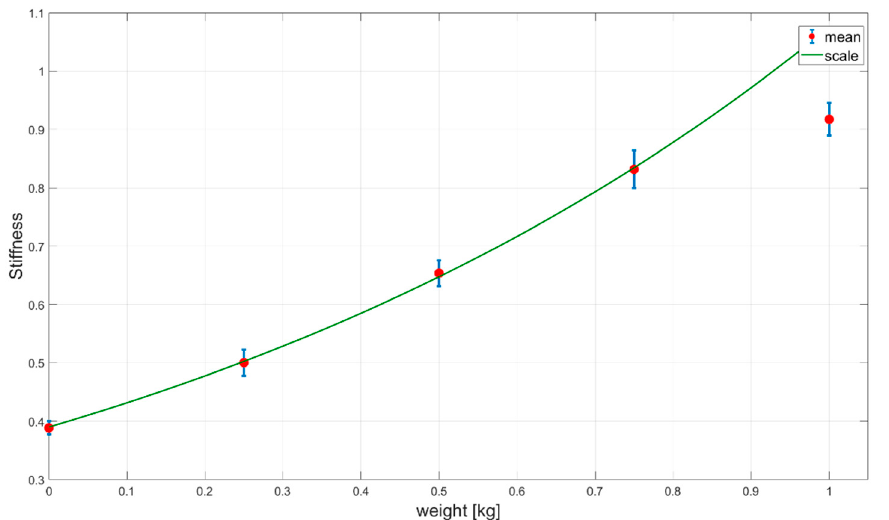
Figure 9. Stiffness fitting curve (green curve) for different “pulling” weights task (E2). Mean value for all participants is presented by red dots and corresponding standard deviation is presented by blue lines.